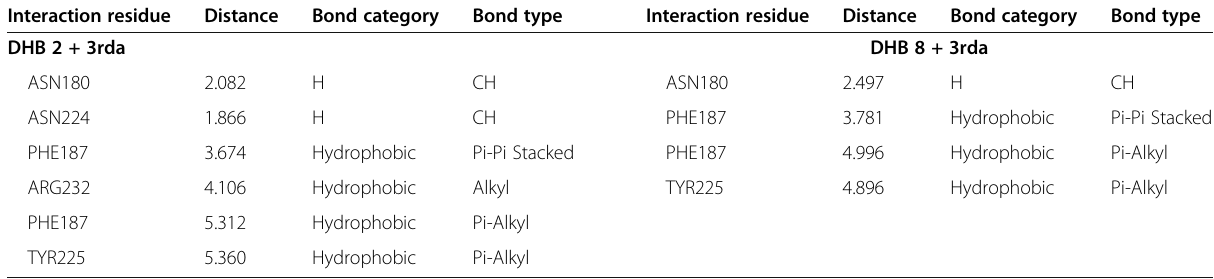
Table 4 Nonbonding interactions of selected two DHB with six proteins (pose predicted by FireDock). CH conventional hydrogen bond, H hydrogen bond, C carbon hydrogen bond (Continued)